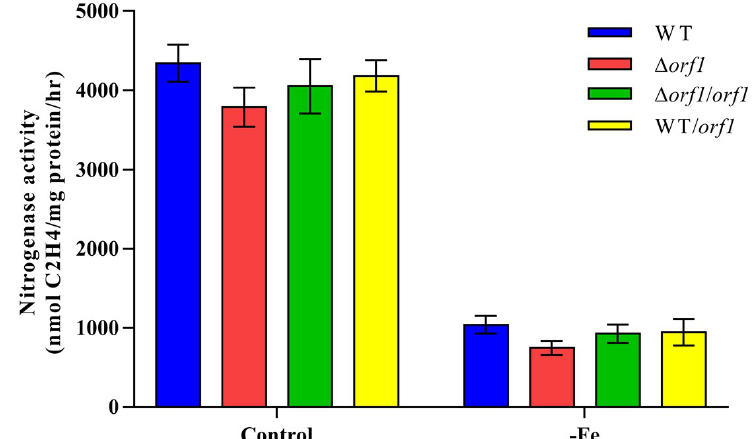
Figure 7. Nitrogenase activity of P. graminis RSA19 (WT), ∆ orf1 (deletion mutant), ∆ orf1 / orf1 (complementation strain) and WT/ orf1 (overexpression strain) under iron limitation. These strains were grown anaerobically in a normal nitrogen-limited medium (Control) and nitrogen-limited medium without ferric citrate (-Fe). The nitrogenase activities of these strains were assayed by C 2 H 4 reduction method and expressed as nmol C 2 H 4 /mg protein/hr.